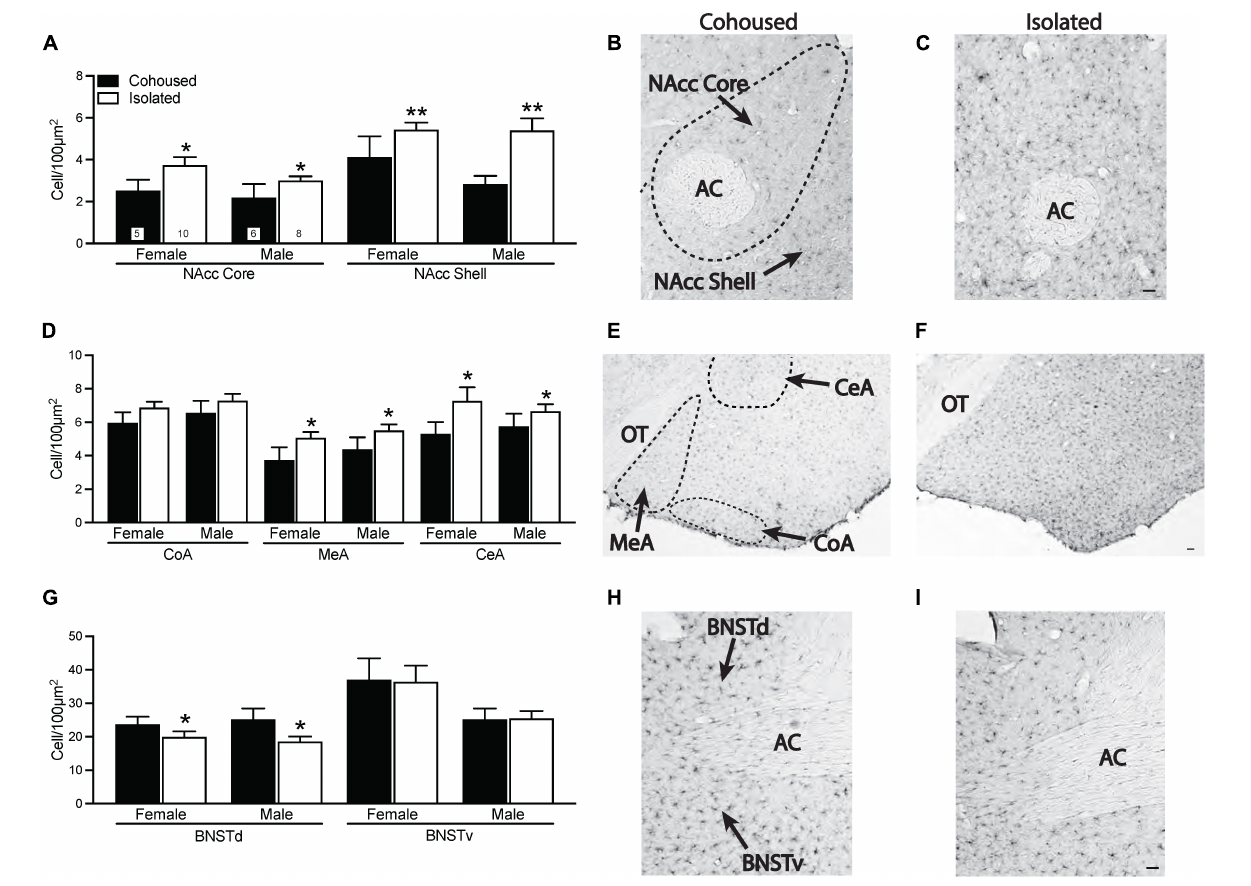
FIGURE 3 | Post-weaning isolation alters ionized calcium binding adaptor molecule 1 (Iba-1) density in a brain region-specific manner. Post-weaning isolation increased Iba-1 cell density in the NAcc Core and Shell (A–C) and in the MeA and CeA (D–F) of the amygdala. Social isolation also resulted in decreased Iba-1 cell density in the BNSTd, but not BNSTv (G–I). Photomicrographs show representative images of Iba-1 staining in the NAcc (B,C) , amygdala (E,F) , and BNST (H,I) . AC, anterior commissure; BNSTd, dorsal region of the bed nucleus stria terminalis; BNSTv, ventral region of the bed nucleus stria terminalis; CeA, central amygdala; CoA, cortical amygdala; MeA, medial amygdala; NAcc, Nucleus Accumbens; OT, optic tract. Bars indicate mean ± SEM. The number within each bar on Panel A indicates the number of animals for each group. * represents p < 0.05, ** represents p < 0.01. Scale bar = 50 µ